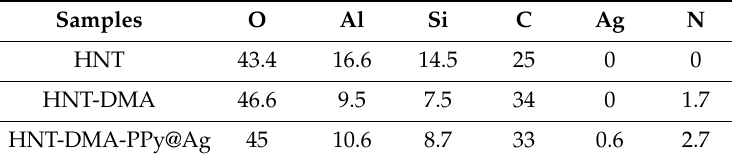
Table 1. EDX analysis of unmodified and treated HNT samples.